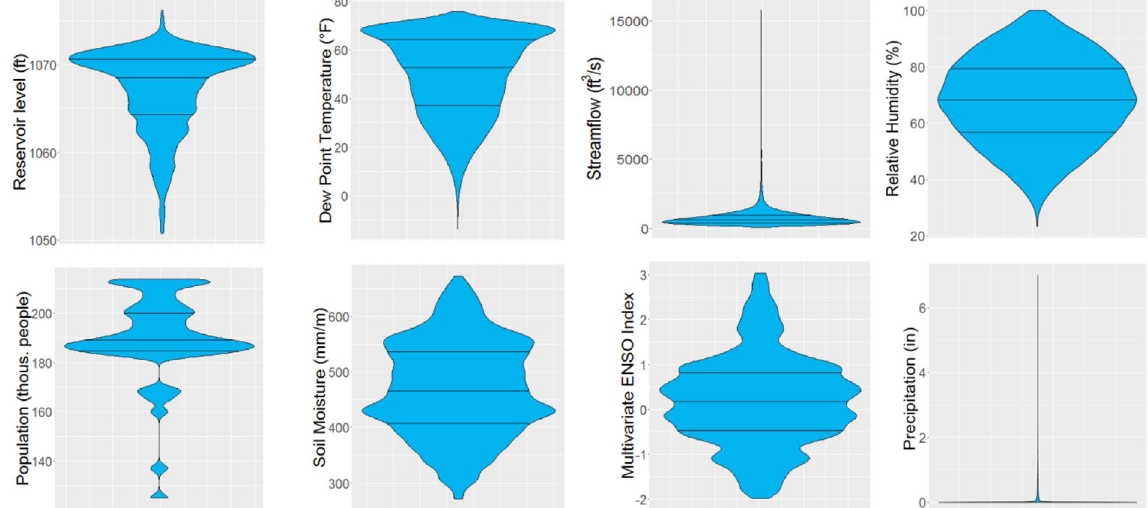
Figure 5. Violin plot showing the density of six variables: reservoir level, dew point, streamflow, humidity, population, soil moisture, ENSO index, and precipitation. Discharge and water use plots are not shown because they have similar patterns to the streamflow and population plots,